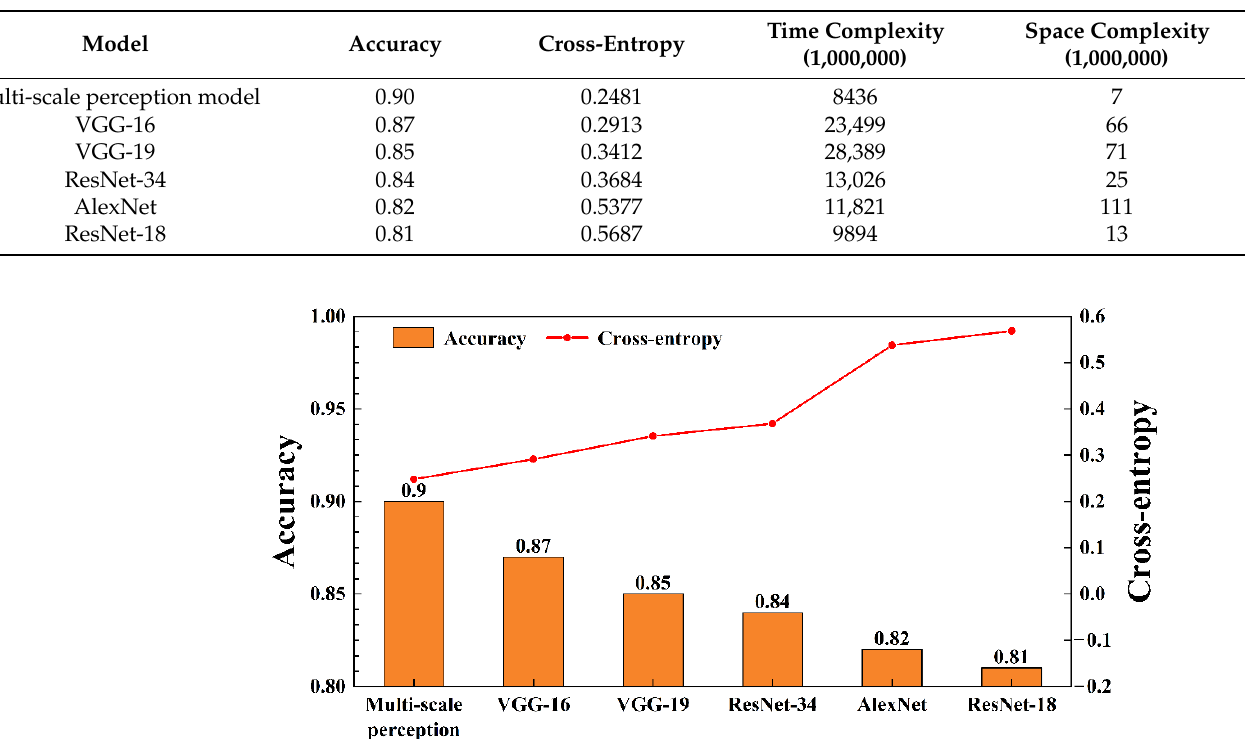
Figure 12. Comparison of the complexity of different models. 4.2. Model Stability Analysis During logging interpretation, the generated variable density image may be dis- turbed and distorted. In order to test whether the multi-scale perceptual convolution neu- ral network can accurately identify, this paper explored the anti-interference of the model. To verify the stability of the model [23], this paper added 3%, 6%, and 9% white noise to the variable density image, as shown in Figure 13. Six different convolutional neural net- works were used to identify the cementing quality. The operation results are as follows: